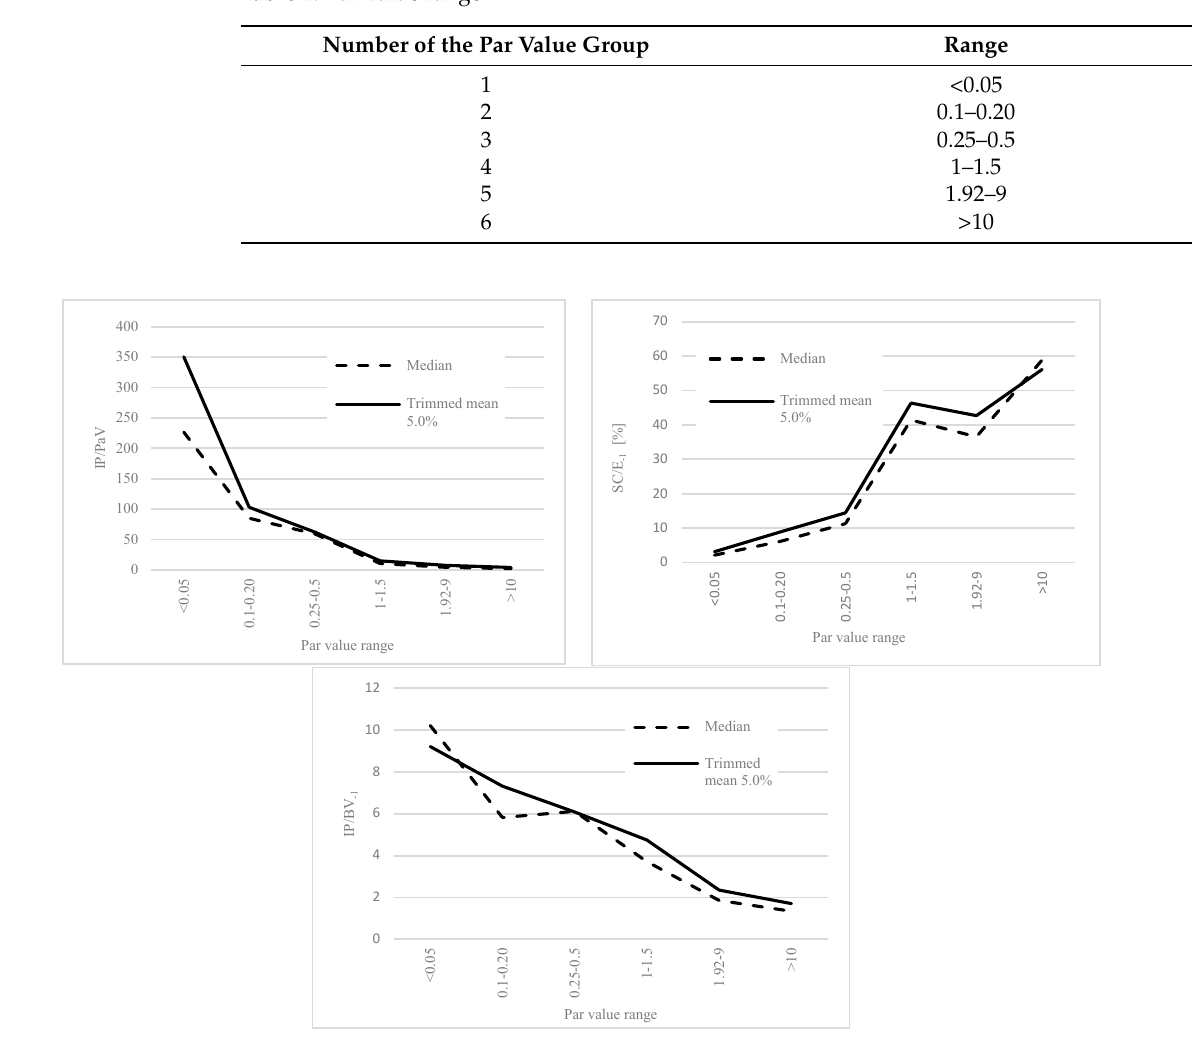
Table 4. Par value range.